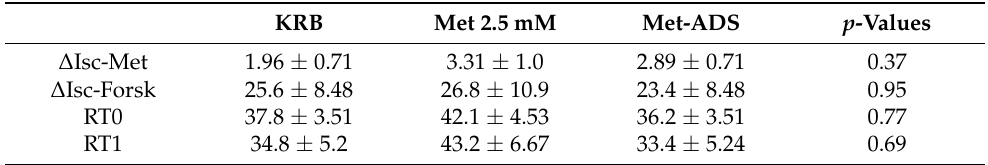
Table 2. Induced ∆ Isc ( µ A) and transepithelial resistance ( Ω ) before (RT0) and 3 h later (RT1) the addition of Kreb’s Ringer Buffer (KRB), 2.5 mM free Met and 2.5 mM Met-ADS in pig jejunum. Forskolin-induced ∆ Isc ( ∆ Isc-Forsk) was evaluated to test tissue viability at the end of the experiment. Data are expressed as mean ± standard